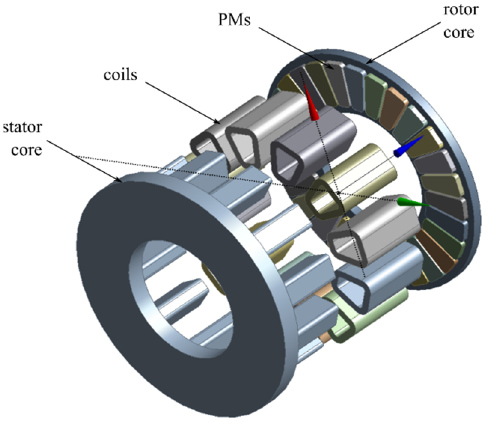
Figure 4. Axial single-stator single-rotor PM machine [65].